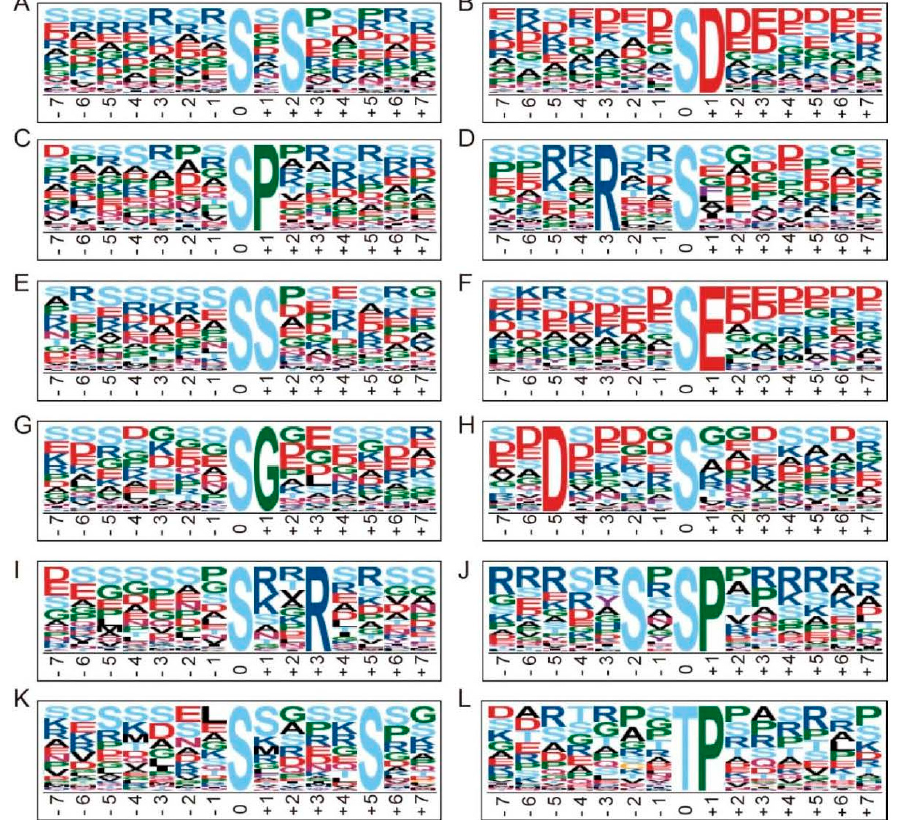
Figure 3. Motif-X analysis of over-represented motifs around the phosphosites. ( A ) ‘sxS’; ( B ) ‘sD’; ( C ) ‘sP’; ( D ) ‘Rxxs’;( E ) ‘sS’; ( F ) ‘sE’; ( G ) ‘sG’; ( H ) ‘Dxxxxs’; ( I ) ‘sxxR’; ( J ) ‘SxsP’; ( K ) ‘sxxxxS’; ( L ) ‘tP’. In motif names, the phosphoserine or phosphorthreonine residue at the position 0 were represented as “s” or ”t”; the conservative and unconservative residues around the phosphosite were represented as uppercase and “x”, respectively.